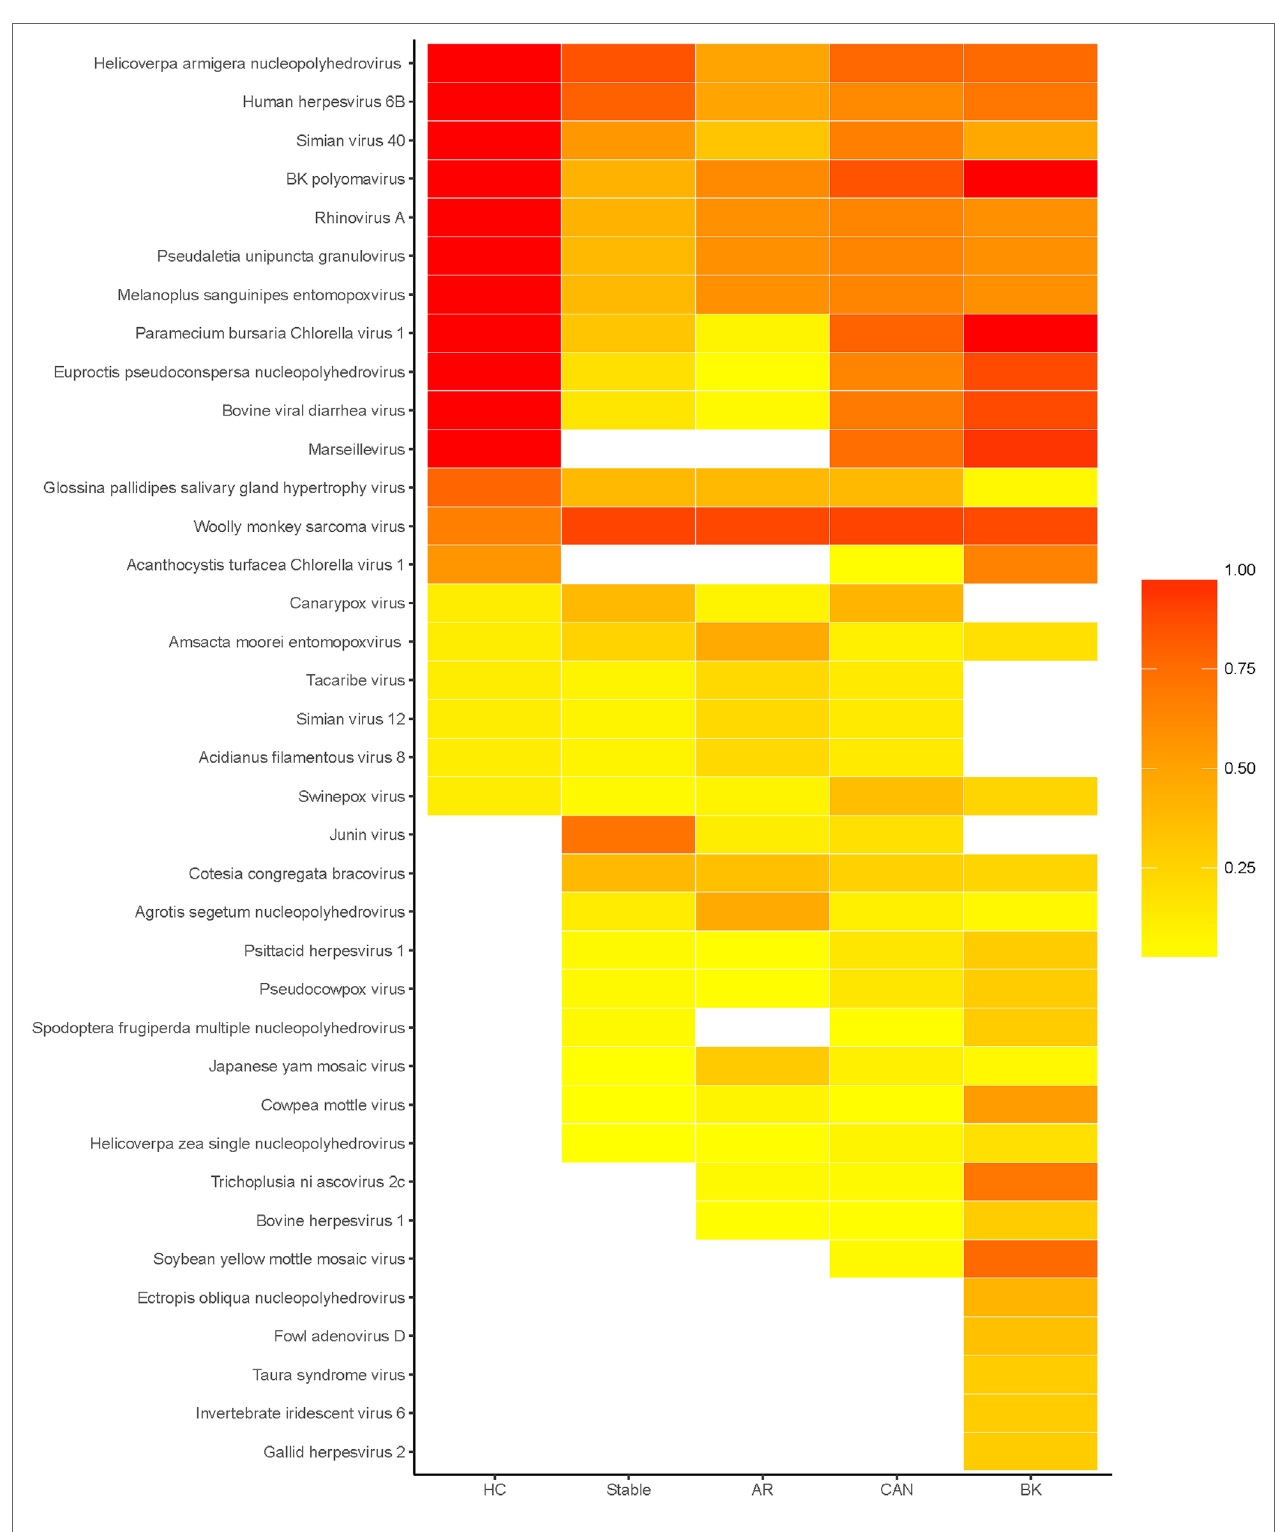
FigUre 2 | Heatmap of prevalence by disease status. Heatmap of the percentage of patients, within each disease status, in which each virus was detected. Total number of unique viruses in each disease status: healthy control (HC) 20, stable 27, acute rejection (AR) 28, chronic allograft nephropathy (CAN) 32, and BK 32.